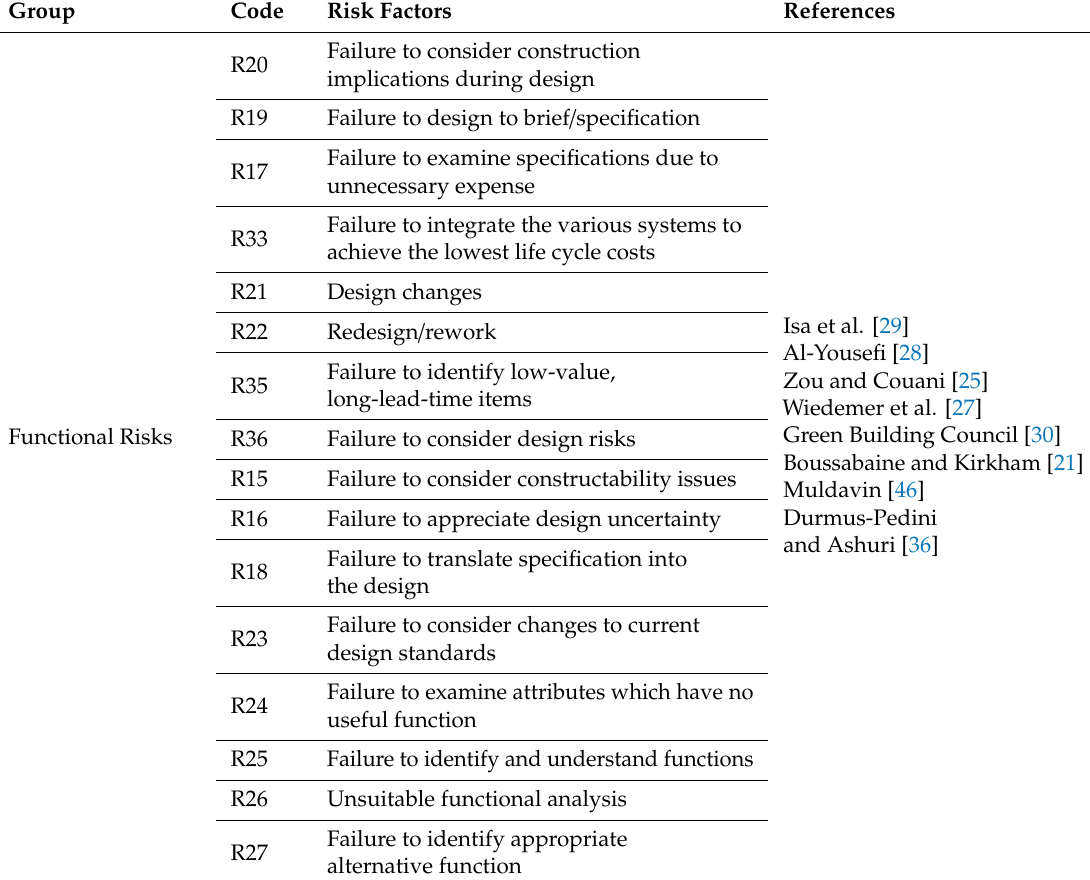
Table 1. Risk Factors impacting the project value created by the green buildings design. Group Code Risk